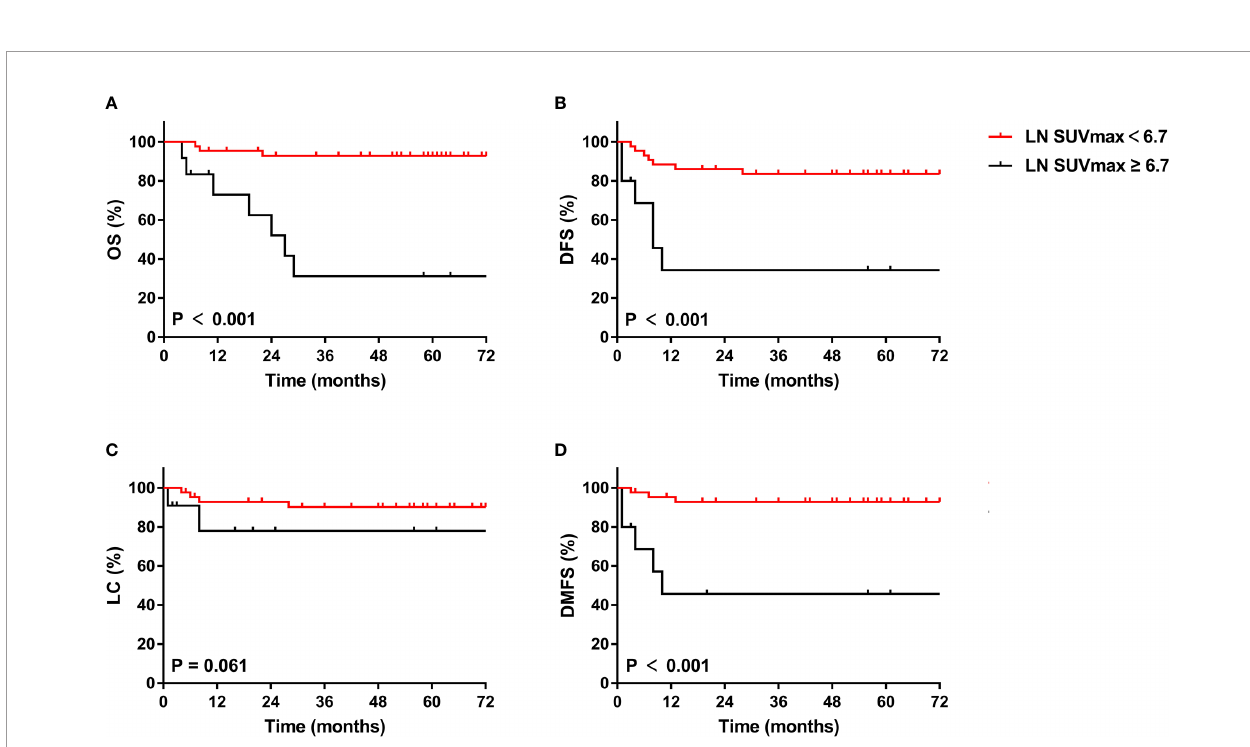
FIGURE 4 | Kaplan-Meier curves of OS (A) , DFS (B) , LC (C) , and DMFS (D) of cervical cancer patients with positive LN for LN SUVmax. OS, overall survival; DFS, disease-free survival; LC, local control; DMFS, distant metastasis-free